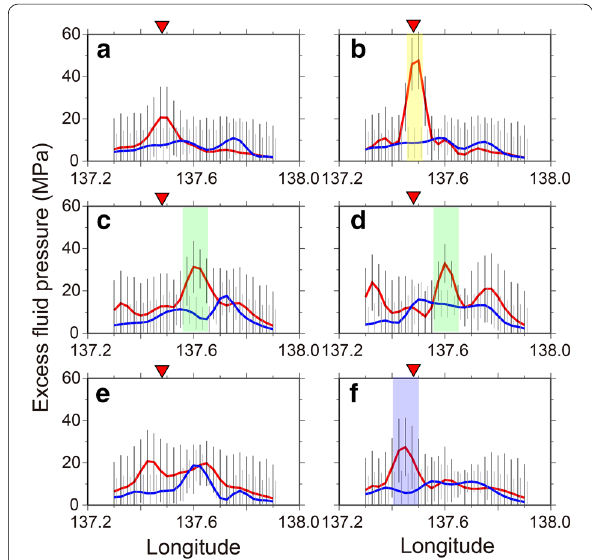
Fig. 6 Stationarity of the pore-fluid pressure field. The profiles and vertical lines in a – f are displayed in the same way as in Fig. 3. The red and blue lines denote the pore-fluid pressures estimated from the dataset from June 2009 to August 2012 (“FMT analysis around Mt. Ontake” section) and that from September 2012 to July 2014, respec- tively. The color shaded zones and red inverse triangles are the same as those in Fig.